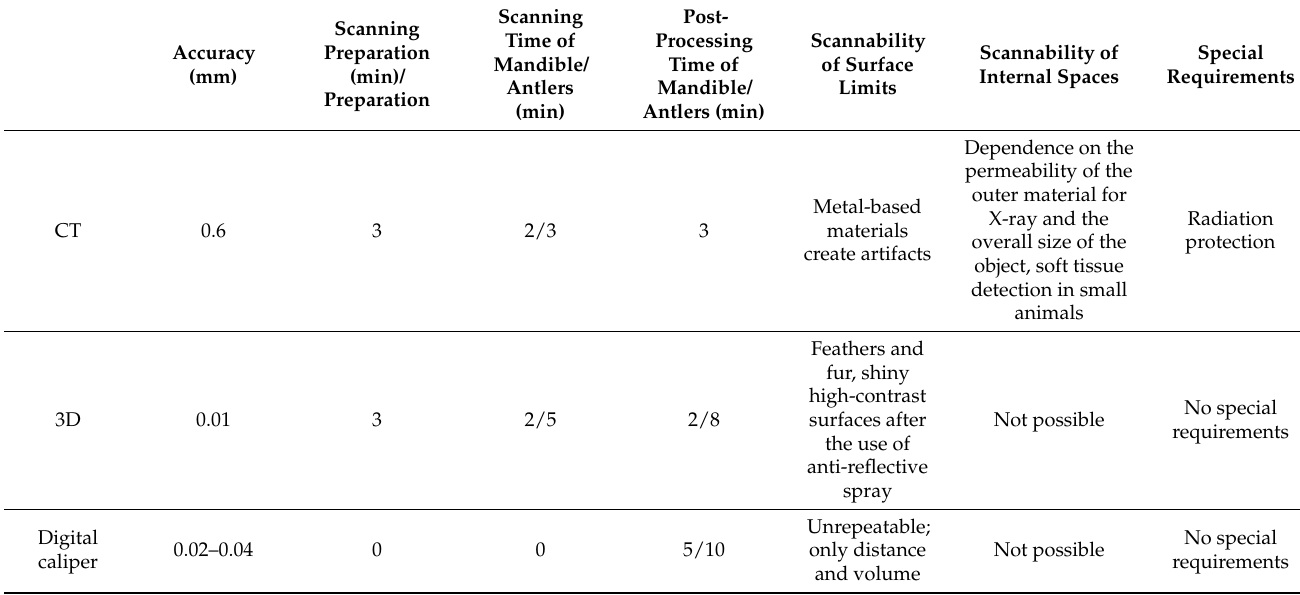
Table 9. Comparison of the limits of both